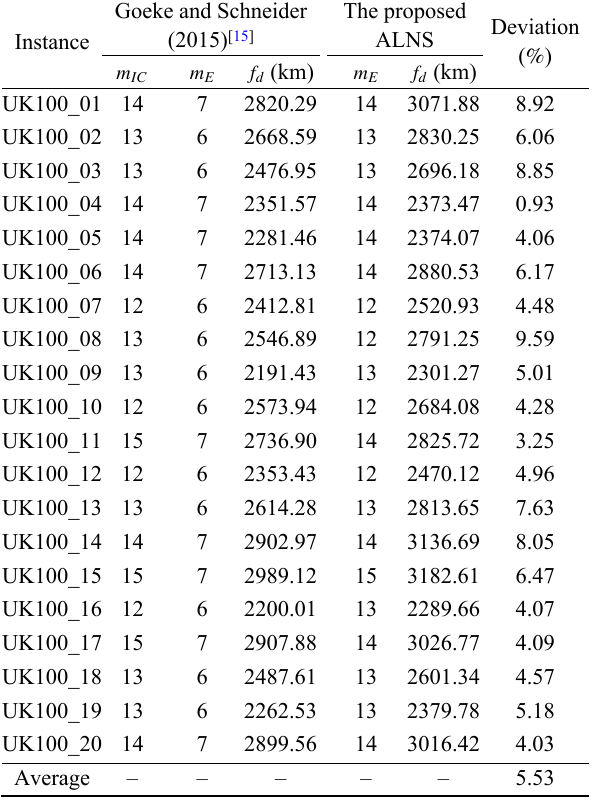
Table 3 Comparison on solutions of the